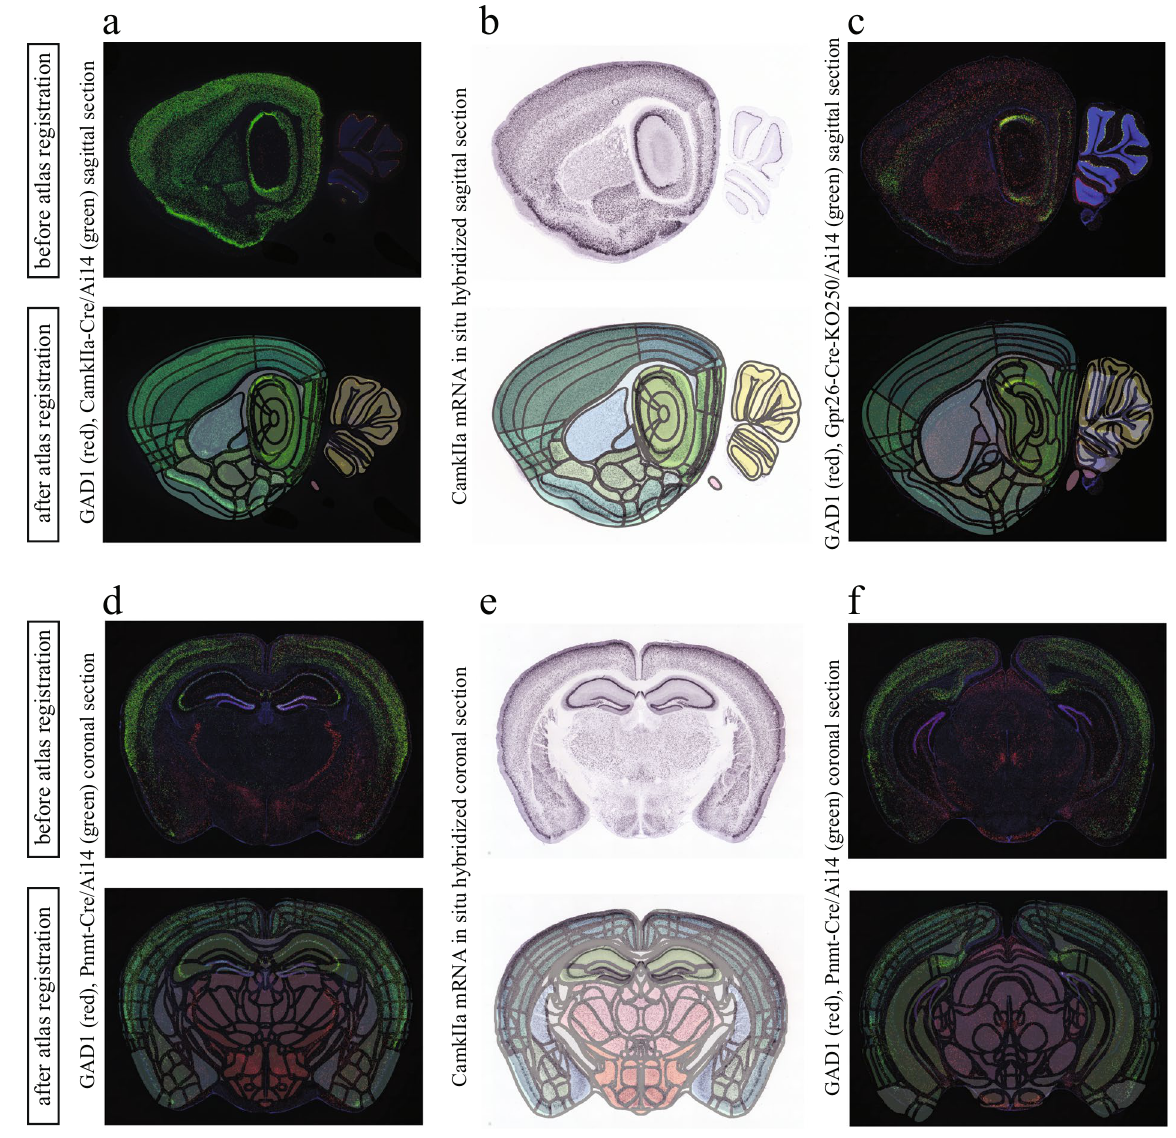
Figure 8. Automated registration of sagittal and coronal mouse brain (bright field and fluorescent) images to the detailed Allen brain atlas. Image registration is performed through the optimization of an affine transformation algorithm by adding a recurrent feedback loop that goes through multiple iterations until the minimum image registration error is achieved. ( a – f ) Sagittal or coronal brain sections obtained from different genetically modified animals are shown before and after automated image registration. The top rows show the brain images before and the bottom rows after image registration with the Allen brain mouse